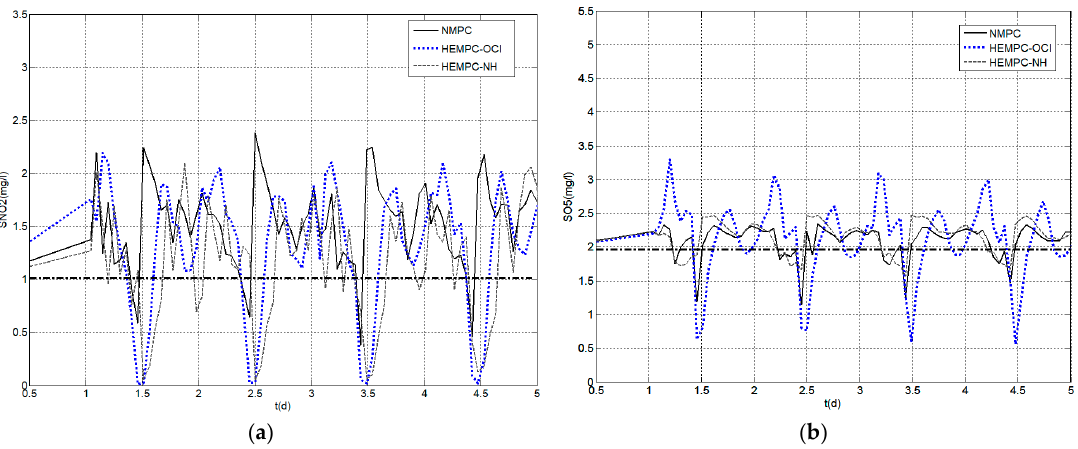
Figure 4. BSM1-controlled variables’ responses under NMPC and economic-oriented tracking controllers (Hybrid-EMPC or HEMPC). ( a ) Nitrates and nitrites concentration in the second rector ( S NO2 ) response ( b ) dissolved oxygen in the last aerobic reactor ( S O5 ) response. NMPC: non-linear model predictive controller; OCI: overall cost index.